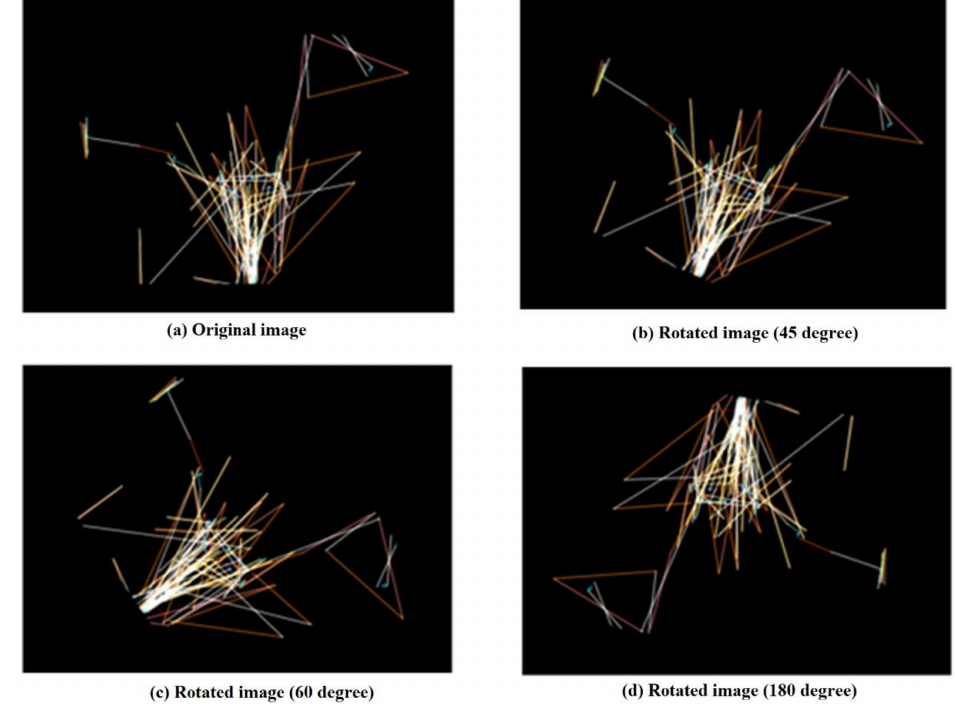
Figure 9. Three variants ( b – d ) of a sample image ( a ) in the original dataset generated by